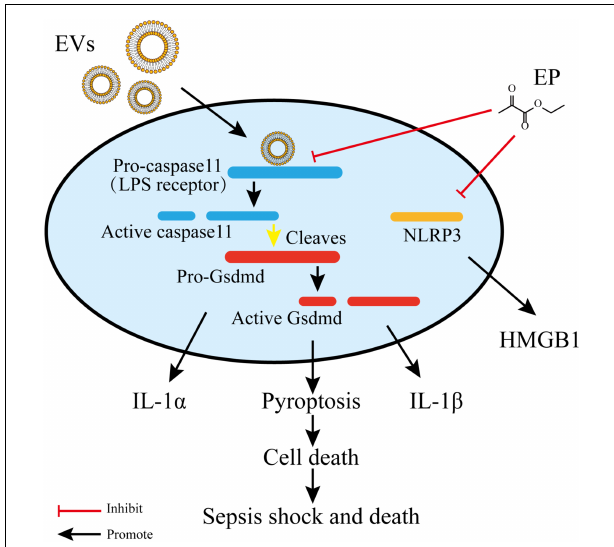
FIGURE 3 | Ethyl pyruvate inhibits caspase-11 expression and NLRP3 activation, which eventually retards pyroptosis and pro-inflammatory responses. Gram-negative EVs carry LPS which are recognized by the receptor and activated caspase-11. Activated caspase-11 then cleaved Gasdermin D (Gsdmd), which produced active Gsdmd to assist in the release of IL-1 α and IL-1 β , thus triggering cellular pyroptosis. Ethyl pyruvate can suppress LPS binding to caspase-11 and decrease the LPS-induced upregulation of caspase-11. In addition, Ethyl pyruvate prevent the activation of NLRP3 inflammasome which resulted in the release of HMGB1.